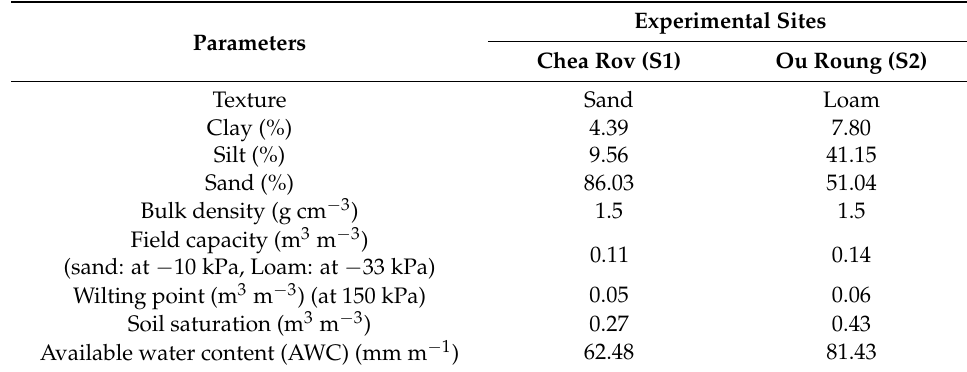
Table 1. Measured physical soil characteristics.